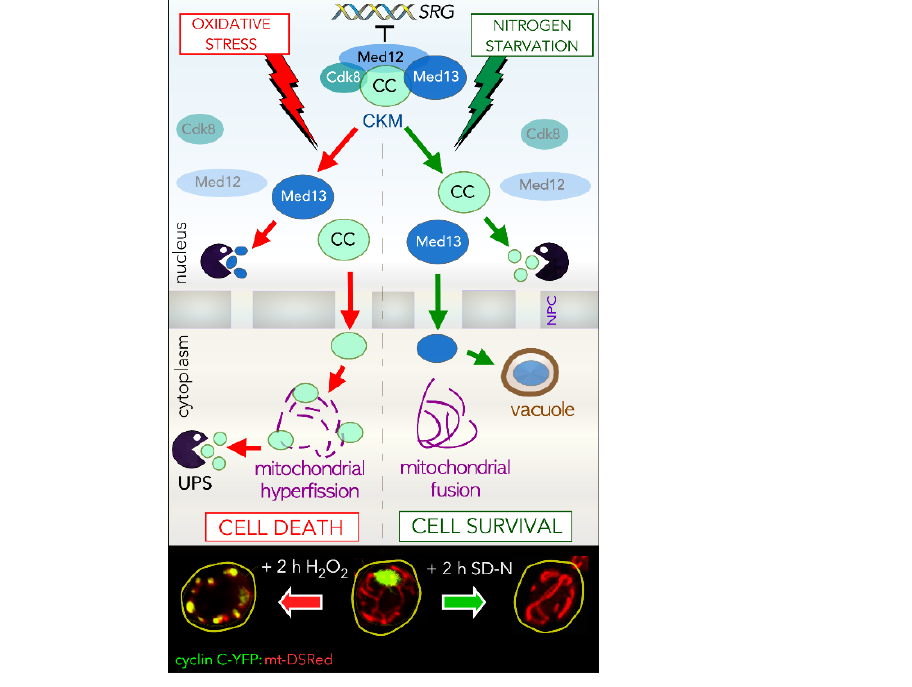
Figure 1. Top panel: Model outlining the different mechanisms used by the CKM to relieve repression on SRG’s in response to either cell death (oxidative stress) or cell survival (nitrogen starvation) cues in yeast. Bottom panel: Live fluorescence images of cyclin C-YFP and DS-Red tagged mitochondria demonstrating the different phenotypes observed after 2 h treatment with H 2 O 2 (left) or following nitrogen starvation (SD-N—right). CKM-Cdk8 kinase module, SRG’s—stress response genes, YFP—yellow fluorescence protein.